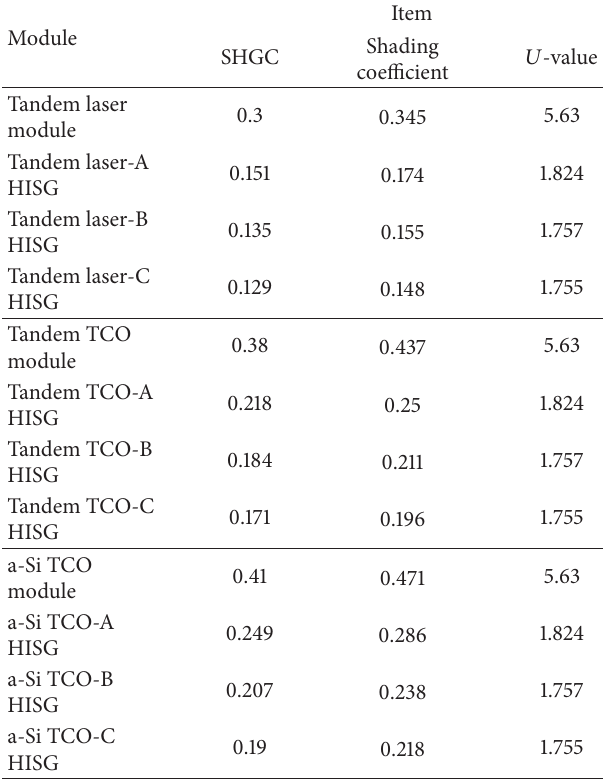
Table3:ThermalpropertiesofthesemitransparentPVmodulesand HISGs.